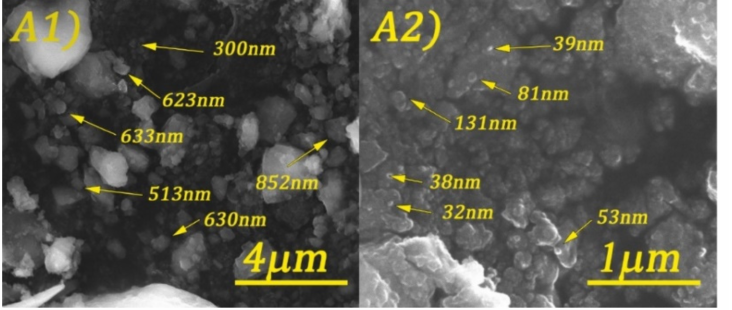
Figure 5. SEM images of CoFe 2 O 4 -0 at different magnifications: 20 kX ( A1 ) and 80 kX ( A2 ).